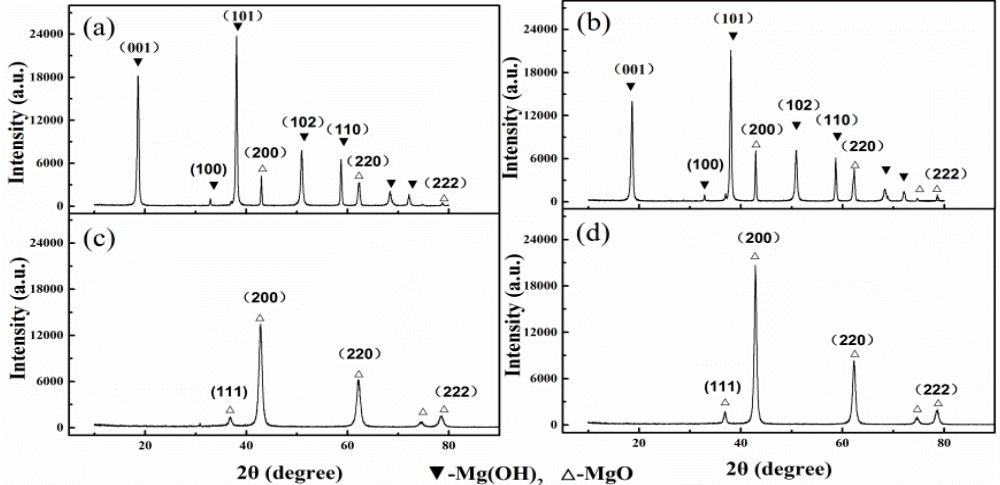
Figure 5. XRD patterns of calcined products: ( a ) Δn Cl− = 21.5 mol/kg, t = 120 min; ( b ) Δn Cl− = 7.5 mol/kg, t = 120 min; ( c ) Δn Cl− = 21.5 mol/kg, t = 0 min; ( d ) Δn Cl− = 7.5 mol/kg, t = 0 min.